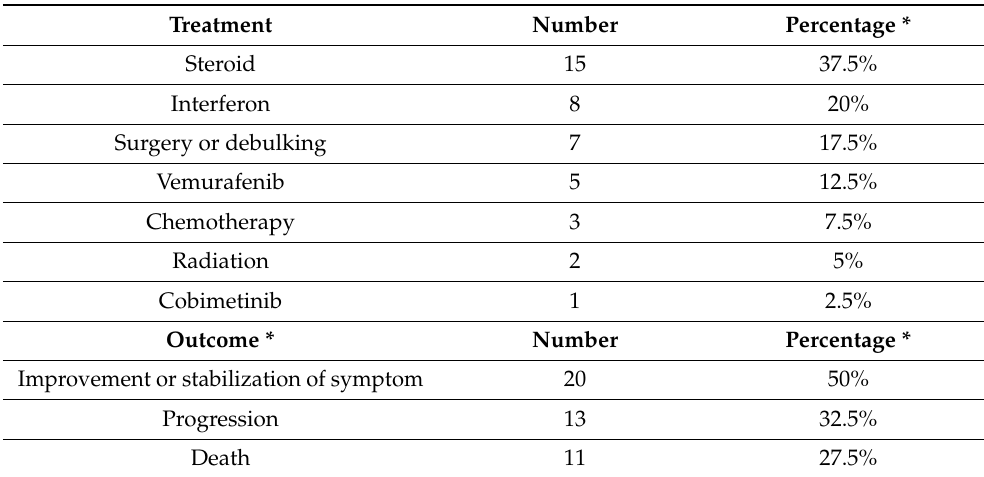
Table 2. Treatments and outcomes of cases in this systematic review.